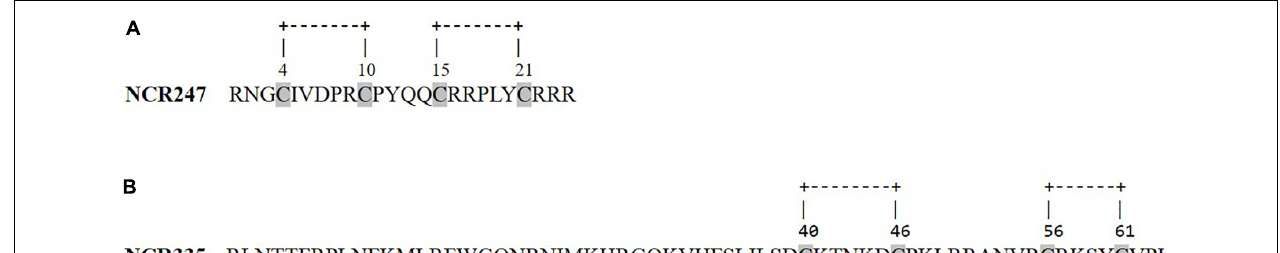
FIGURE 3 | Primary sequences and disulfide bonds of NCR247 (A) and NCR335 (B) peptides.